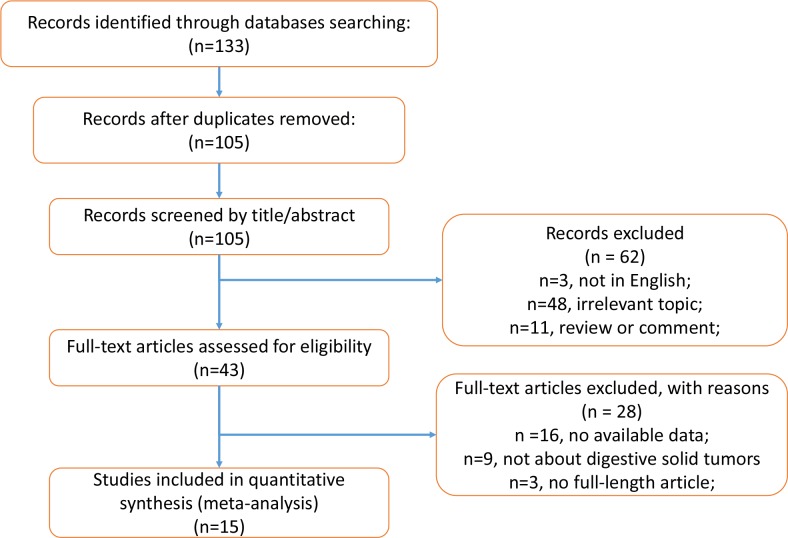
Flow diagram of study selection.